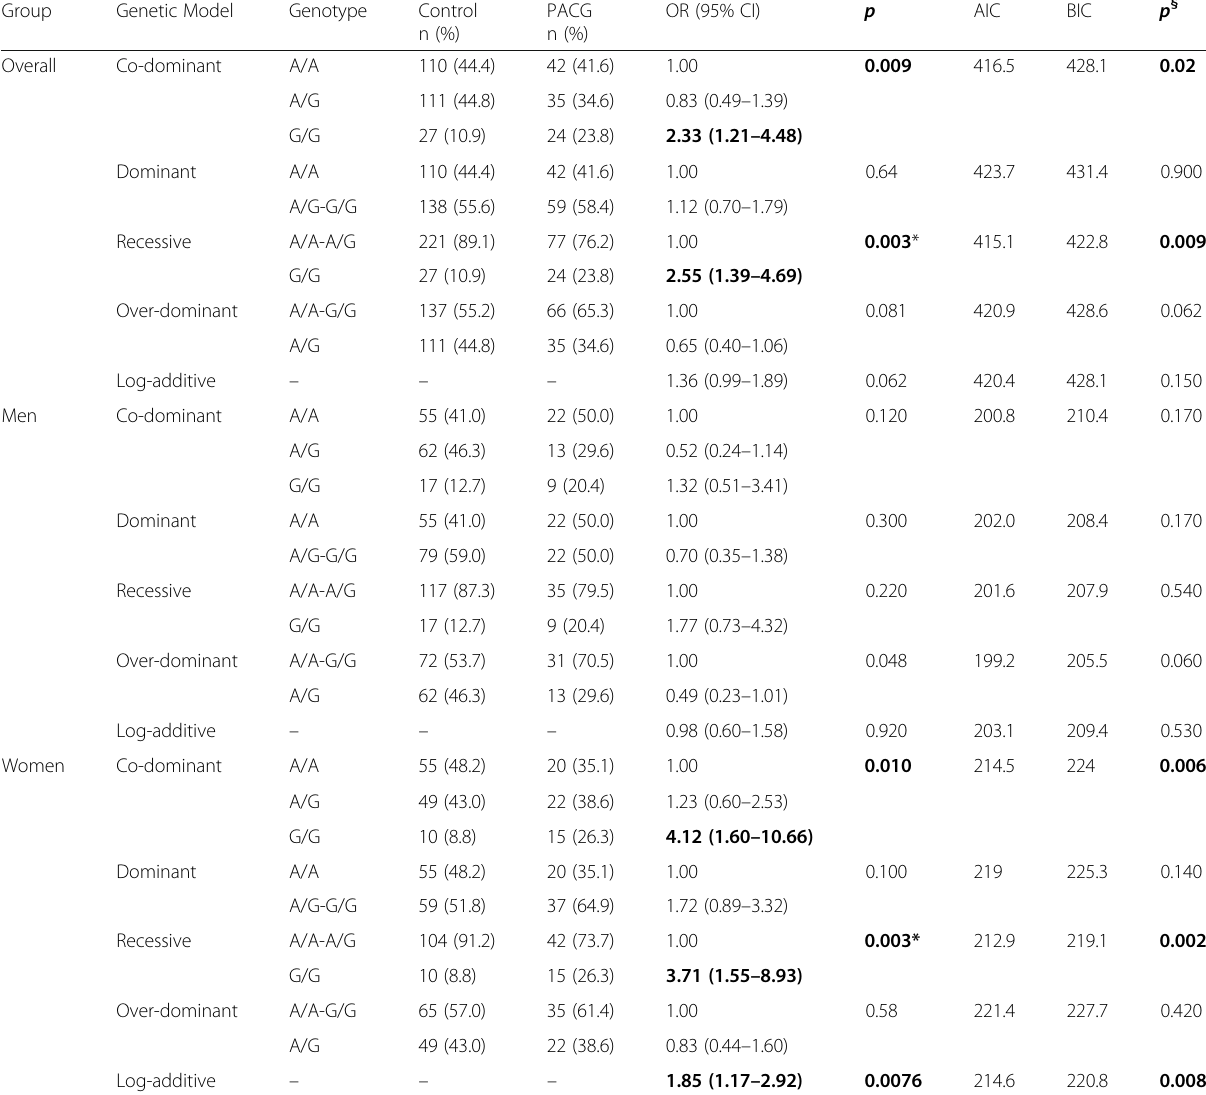
Table 3 Association analysis of rs12997 variant in ACVR1 with primary angle-closure glaucoma